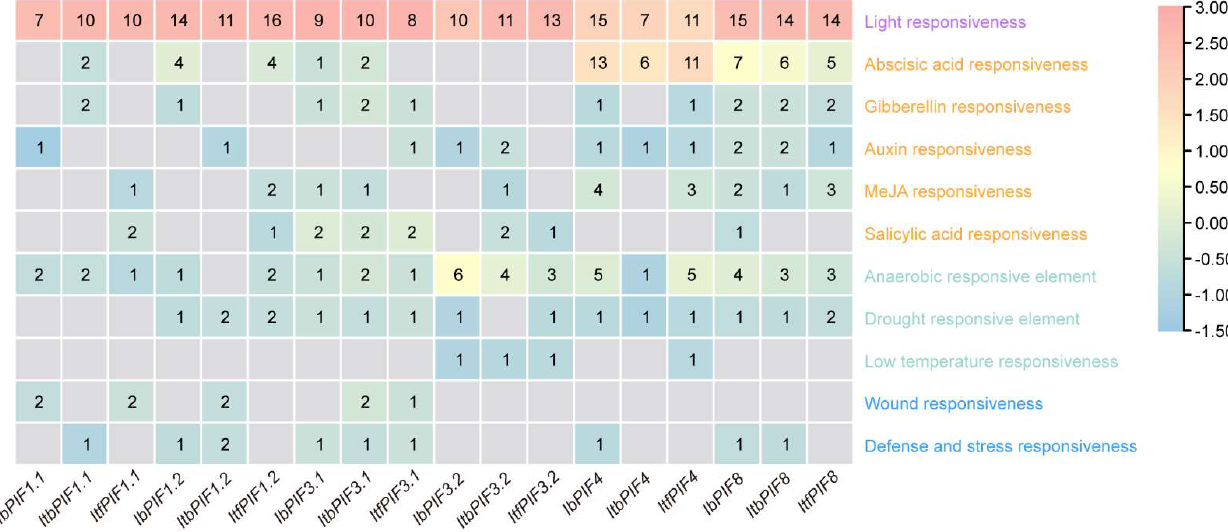
Figure 4. Analysis of cis -elements of IbPIFs in I. batatas , I. triloba, and I. trifida . The degree of red color represents the number of cis -elements upstream of the PIFs .